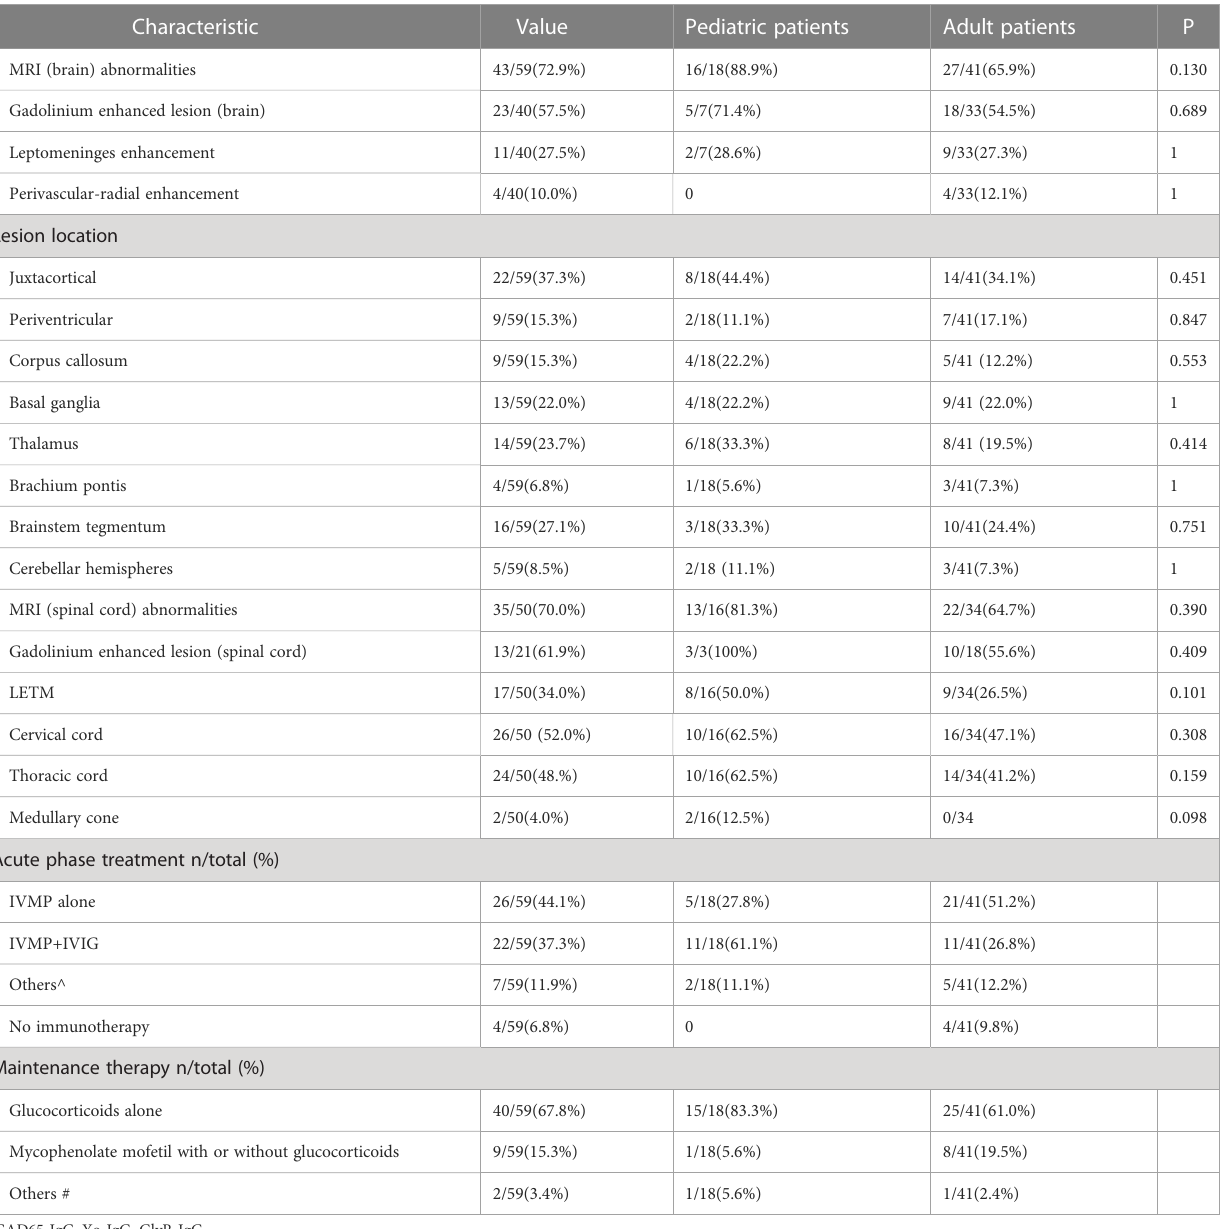
(Table 2). One of the most common imaging features was lesions in the bilateral thalamus (20.3%) and bilateral basal ganglia (18.6%) (Figure 2). In 6/59 (10.2%) patients, reversible splenial lesion syndrome (RESLES) was discovered. Among the 40 patients who underwent brain gadolinium enhancement MRI, 23 had enhanced lesions, 11 had leptomeningeal enhancement, but only 4 patients